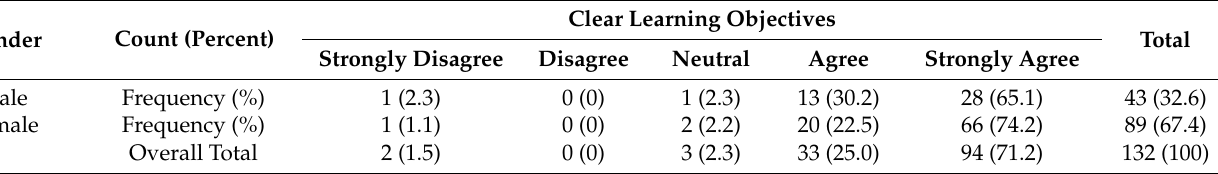
Figure 4. Muscle functionality differences before and after the course. ( a ) Core muscle and upper muscle endurance and ( b ) flexibility. * Wilcoxon signed rank test. Table 3. Students’ perceived rating of course satisfaction derived from the